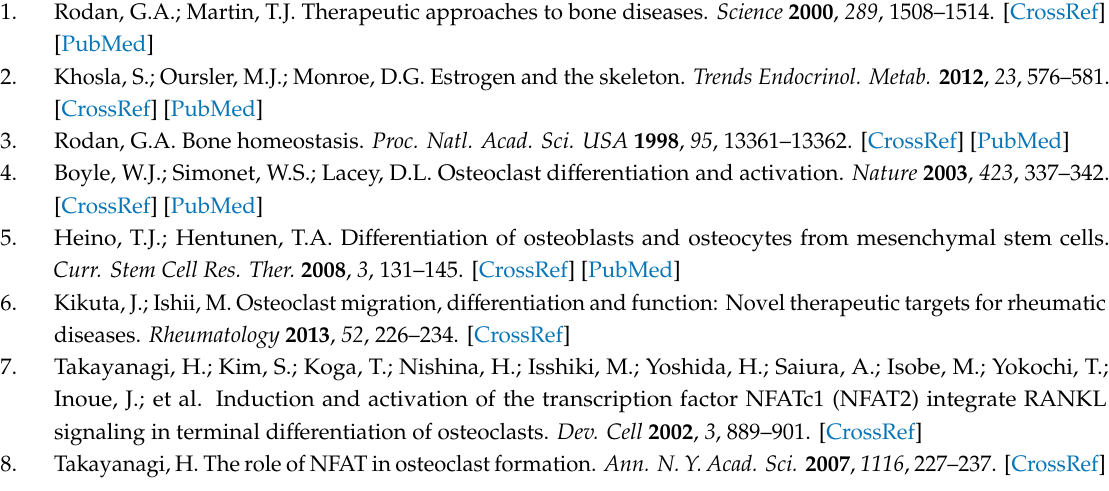
Figure S1: anti-osteoclastogenesis activities of sesquiterpenoids isolated from Salvia plebeia EtOH extract, Figure S2: HPLC chromatogram of eudebeiolide B (upper panel) and Salvia plebeia EtOH extract (lower panel), Figure S3: cytotoxicity of eudebeiolide B on MC3T3-E1 cells. MC3T3-E1 cells were seeded in 96 well plate and treated with indicated concentration of eudebeiolide B. After incubation mtt assay was performed to obtain cell viability. Values are expressed as the means ± S.D of three individual experiments. * p < 0.05 and ** p < 0.01 versus control group obtained through one way ANOVA followed Dunnett’s test, Table S1: total contet of compounds in ethanol extract of Salvia plebeia R. Br. (2.6